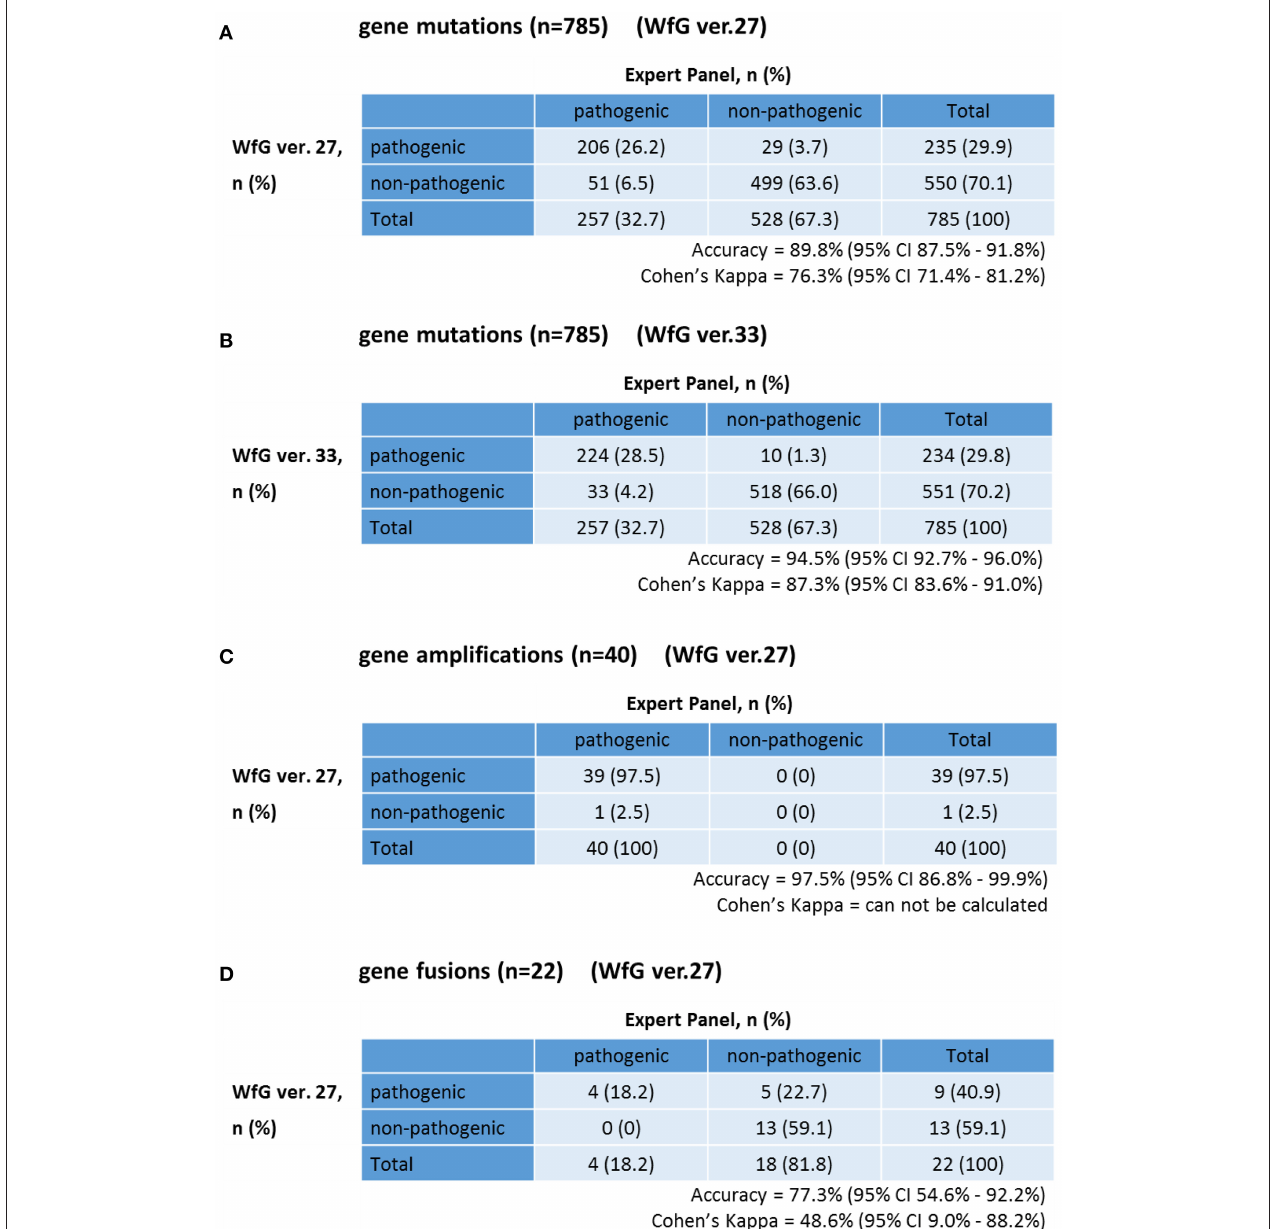
FIGURE 4 | Concordance of pathogenic evaluations of gene mutations, gene amplifications, and gene fusions between the expert panel and WfG (A). Concordance of pathogenic gene mutation detection using WfG ver. 27 (B) . Concordance of pathogenic gene mutation detection using WfG ver. 33 (C) . Concordance of pathogenic gene amplification detection using WfG ver. 27 (D)